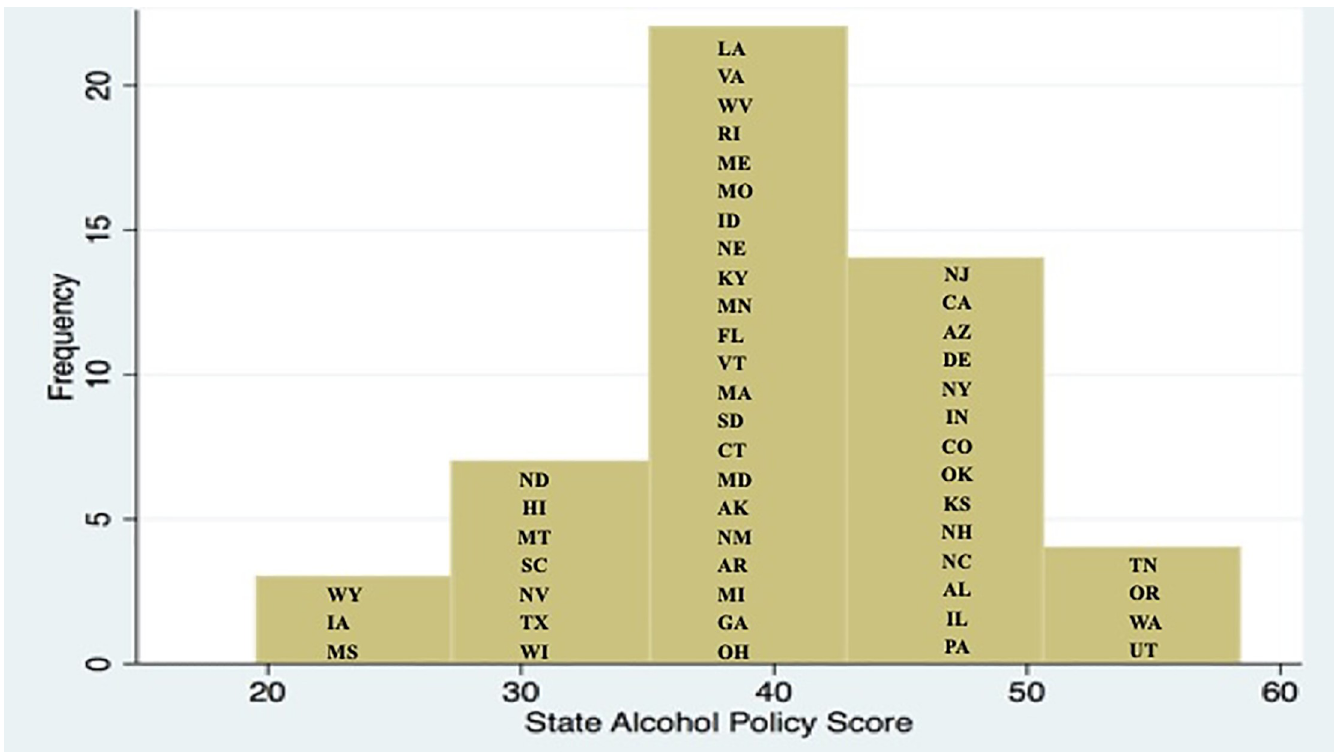
Fig 1. Distribution of State Alcohol Policy Score (SAPS), 2007.